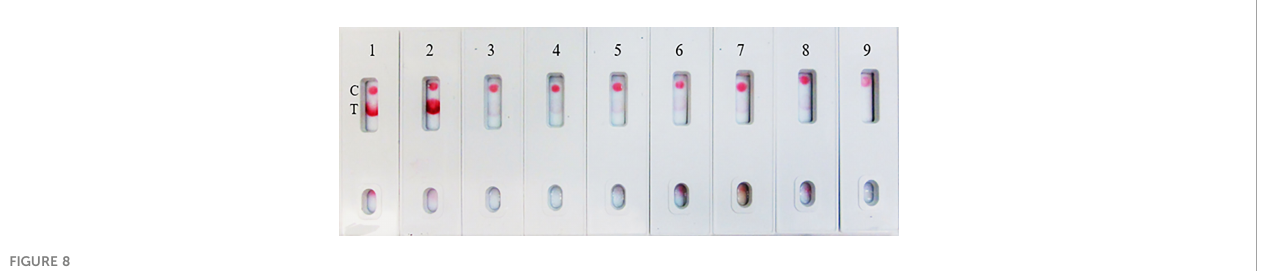
FIGURE 8 LFIA Speci fi city/Cross-reactivity with Respiratory Virus Panel. 1. NR-52397 SARS-CoV-2 spike protein (positive control), 2. NR-52366 SARS-CoV-2 RBD protein (positive control), 3. NR-28528 Human Respiratory Syncytial Virus A1998/12-21, 4. NR-4052 Respiratory Syncytial Virus B1, 5. NR-12149 Respiratory Syncytial Virus A2, 6. NR-51452 Rhinovirus Type-35 (164A), 7. NR-51453 Rhinovirus Type-40 (1794), 8. NR-22234 Human Metapneumovirus, 9. NR-53258 Vero Cell E6 Lysate (negative